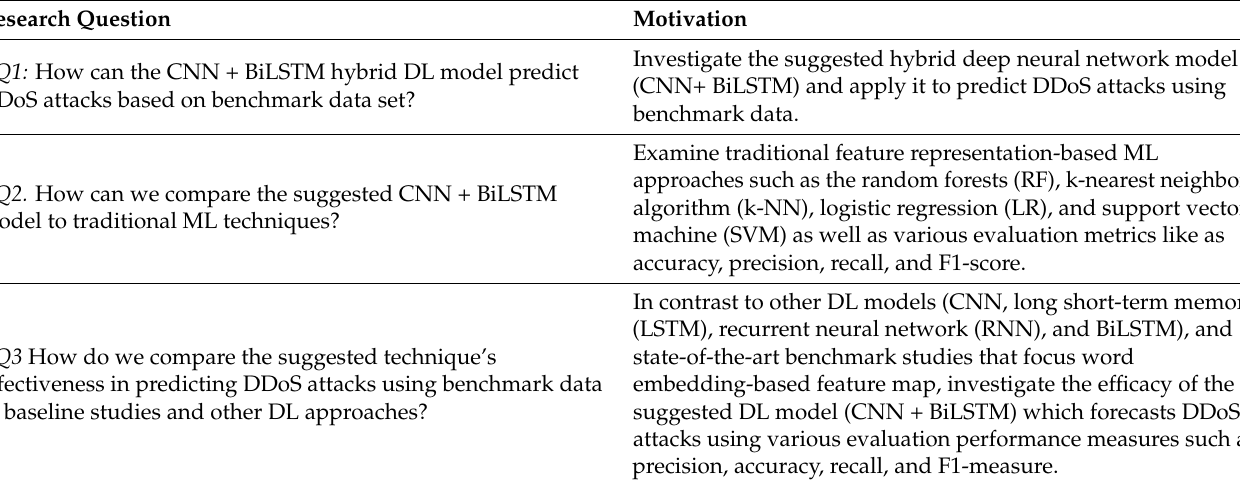
Table 1. Research